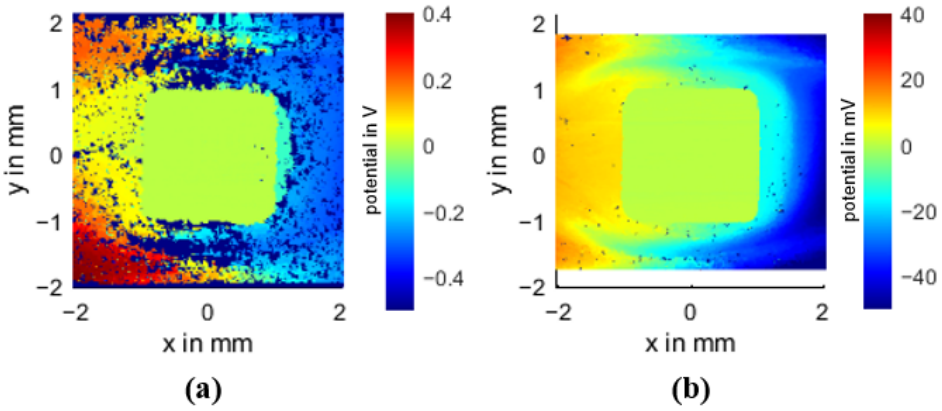
Figure 17. Measured potential fields of the pin areas of the specimen PC CF20_4 mm ( a ), and PA CF30_5 mm ( b ).